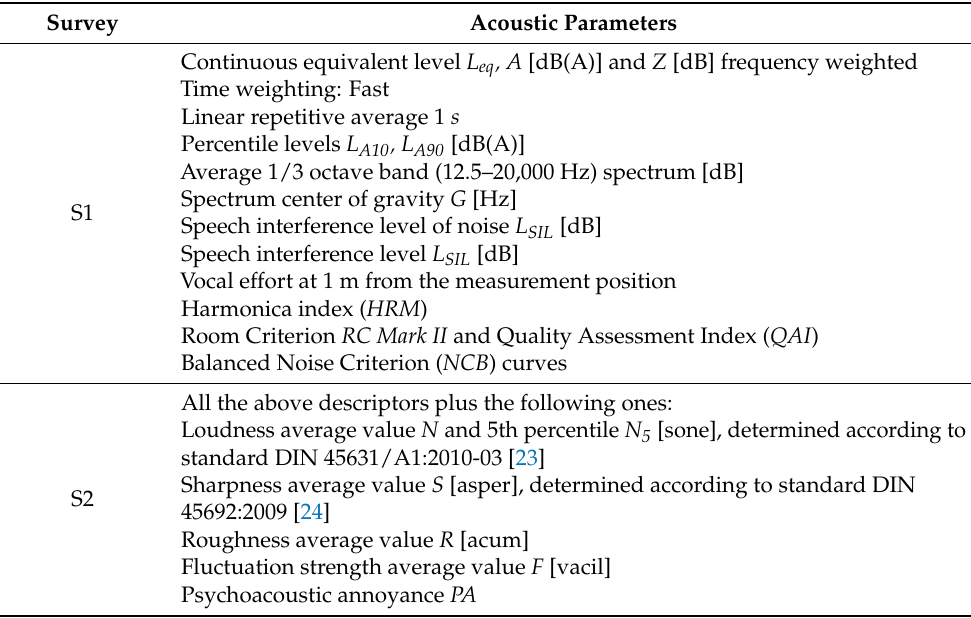
Table 2. Collected acoustic data in the